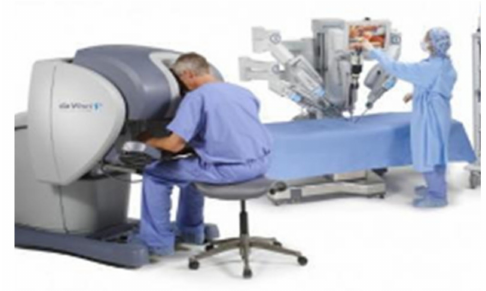
Figure 1. “Da Vinci” surgical